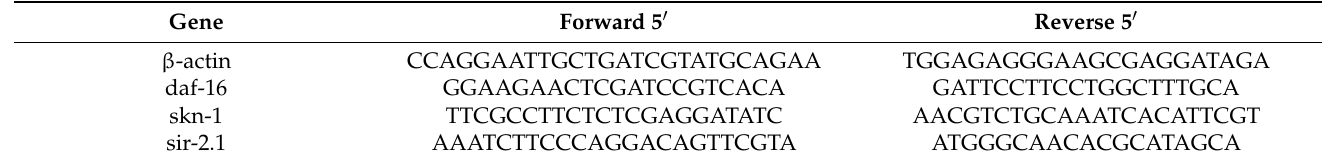
Table 4. Real-time quantitative PCR primers for antioxidant genes of C. elegans